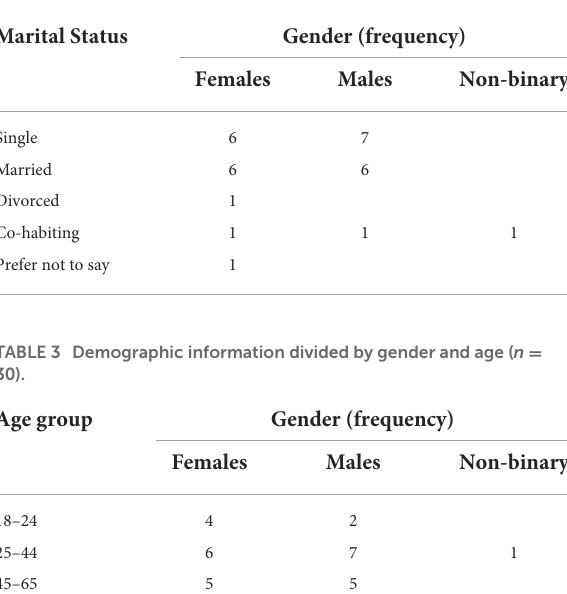
TABLE 4 Demographic information on occupations ( n =